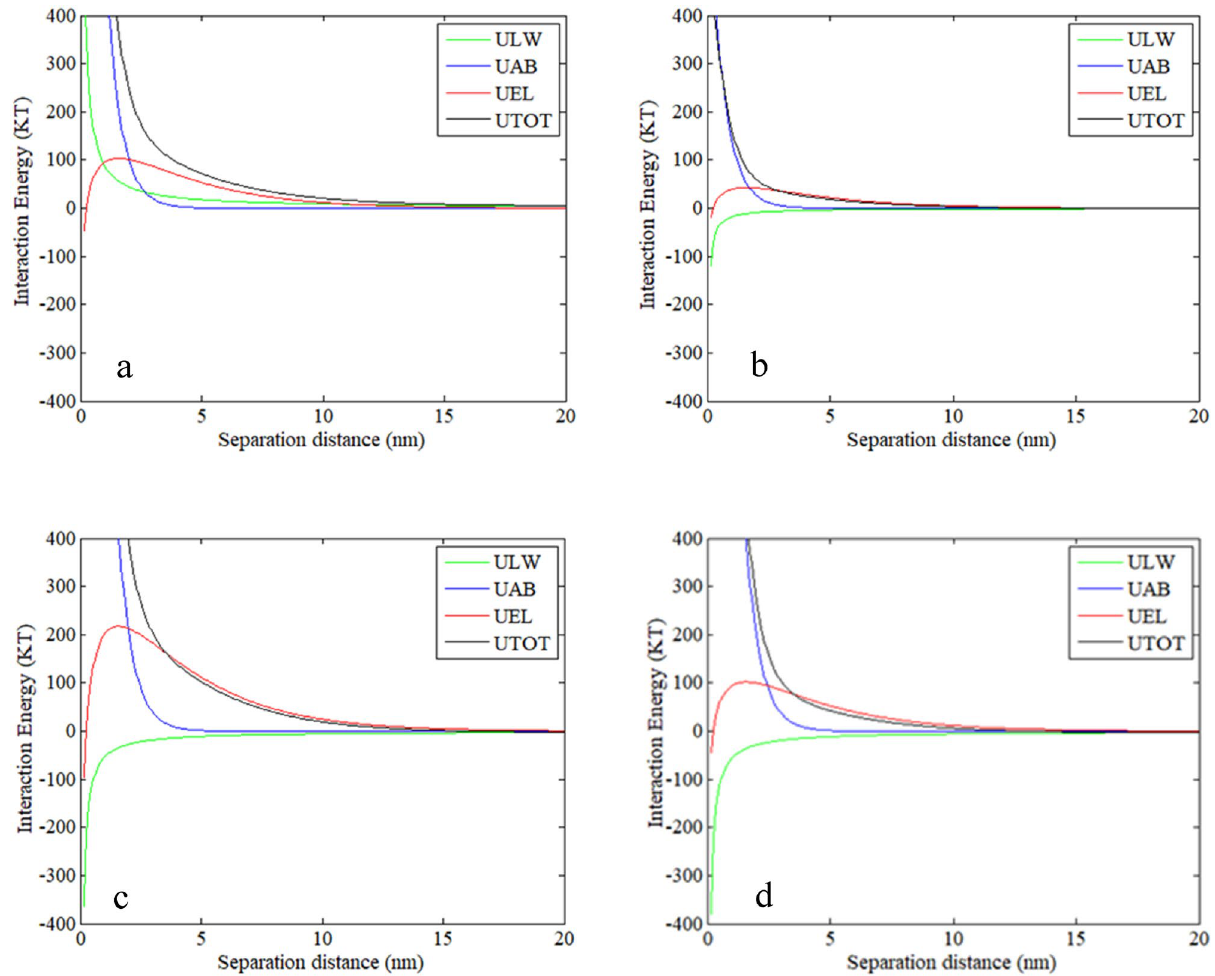
Figure 8. Interaction energy profiles between clean membrane surface membrane and CV-IOM foulants using the XDLVO theory as a function of separation distance, ( a ) HPO, ( b ) TPI, ( c ) C-HPI, ( d )